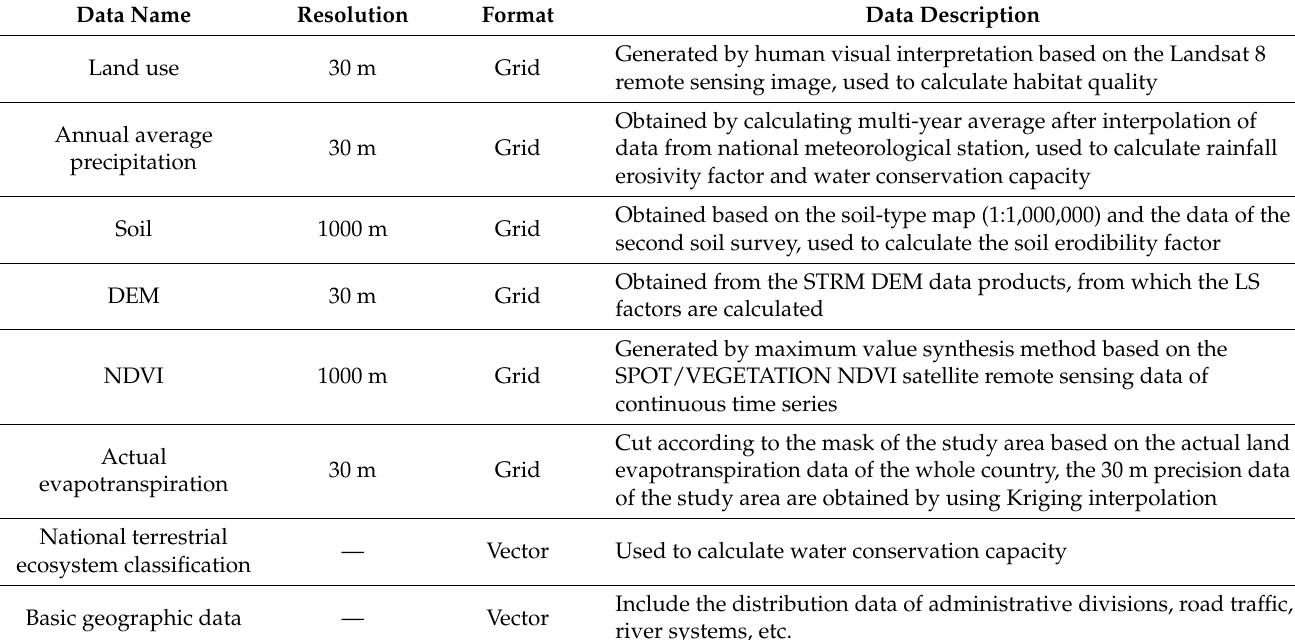
Table 1. Basic introduction of research